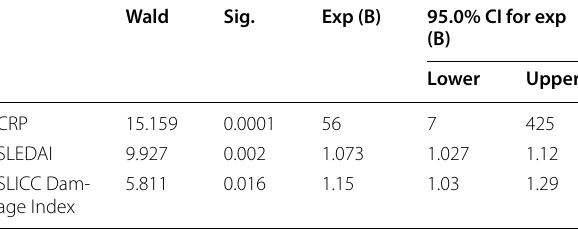
The model is significant P